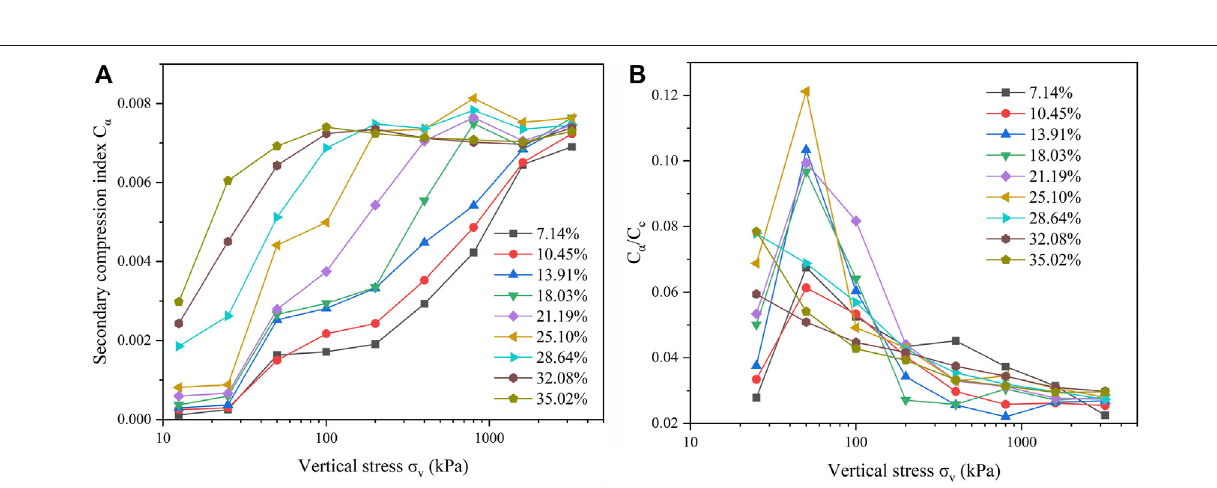
Frontiers in Earth Science |